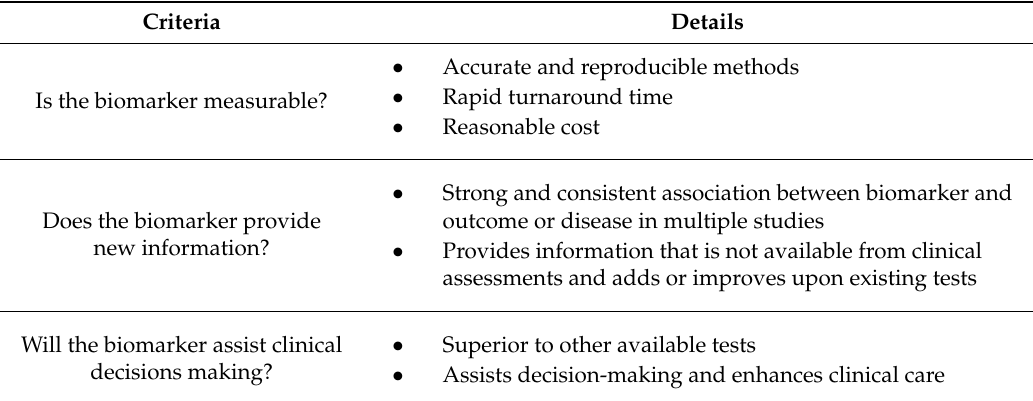
Table 3. Properties of a clinically useful